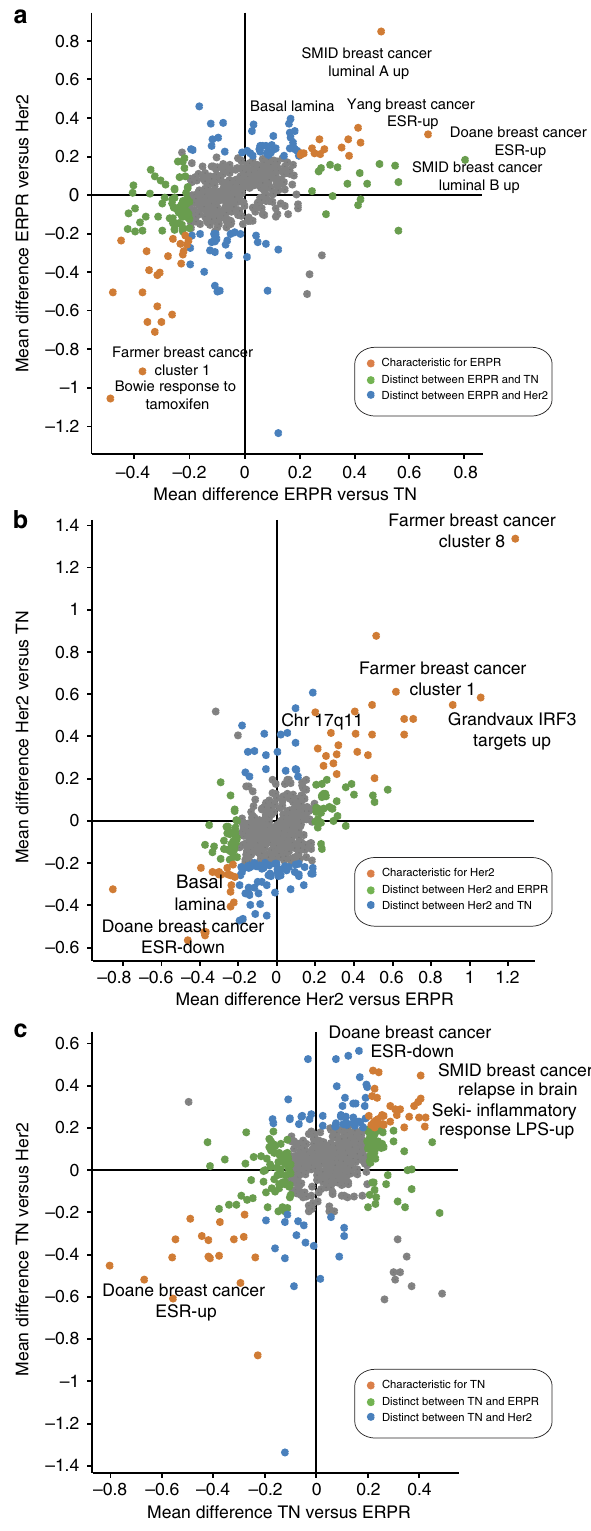
Figure 2 | Molecular signatures database (MSigDB) analysis. Enrichment analysis of molecular signatures from the MSigDB database was performed on the average protein fold changes between the ER ( a ), Her2 ( b ) and TN ( c ) subtypes. Molecular signatures that differentiate one subtype with respect to both other subtypes are shown in orange, whereas categories that differ only between two subtypes are shown in blue or green. Complete list is given in Supplementary Data